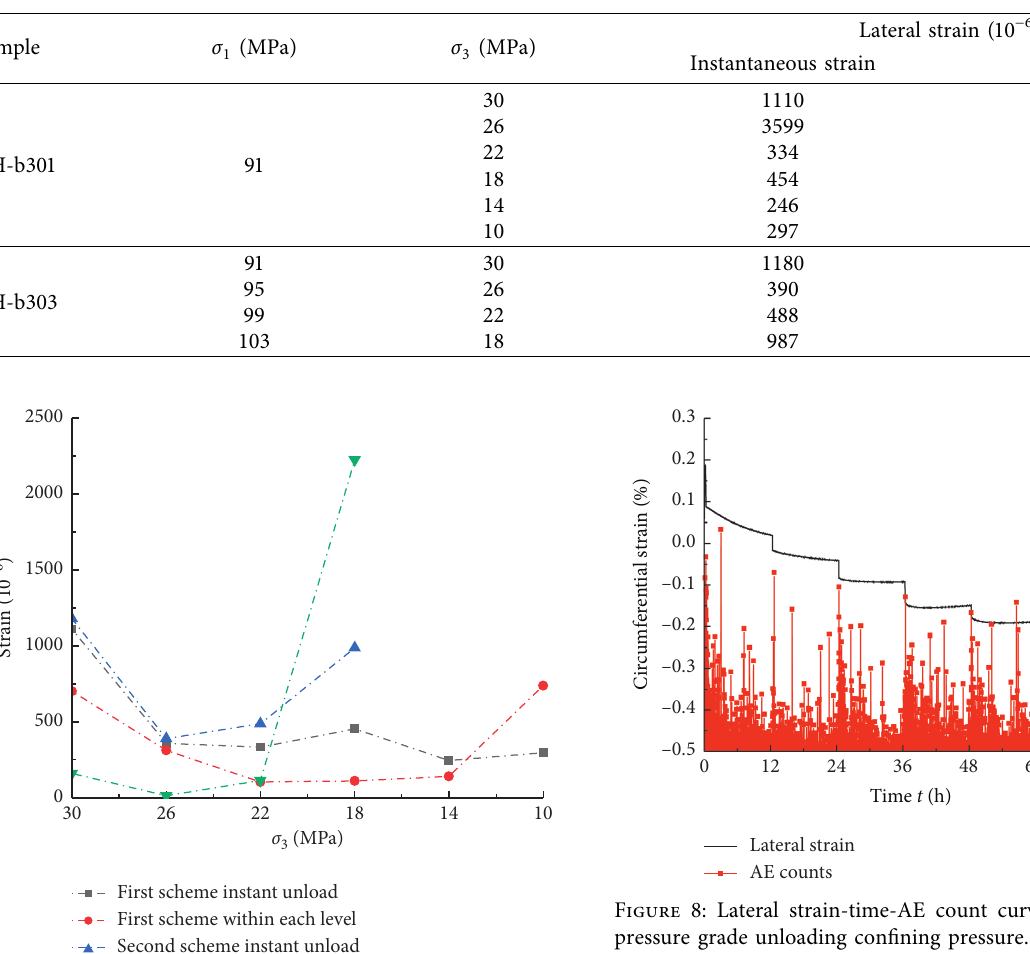
Table 3: Lateral strain values under two test schemes.